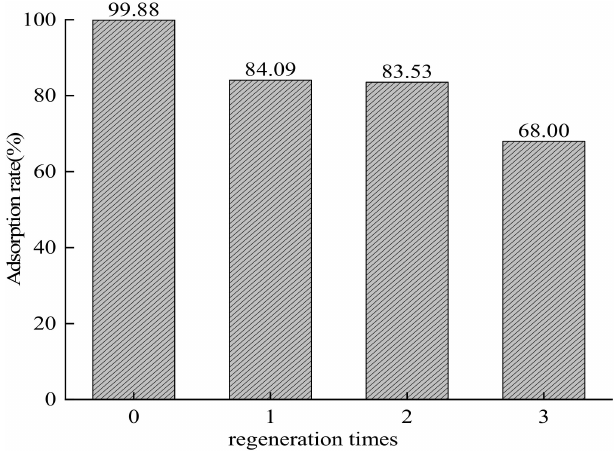
Figure 14. Effect of continuous regeneration cycles on the adsorption rates of the